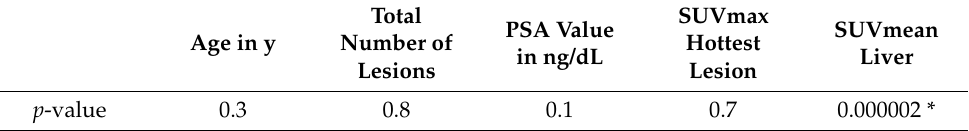
Table 2. Results of a Student’s t -test for outlining potential significant differences between the two patient cohorts that were either examined with [ 64 Cu]-DOTAGA-PSMA PET–CT or [ 18